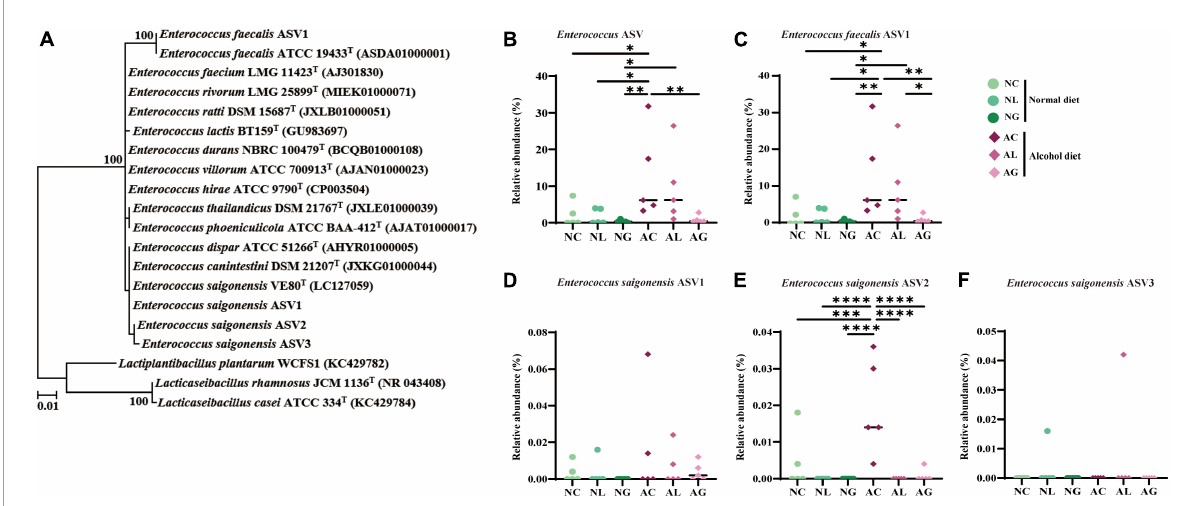
FIGURE6 Phylogenetic analysis and relative abundance of the amplicon sequence variants (ASVs) of Enterococcus . The ASVs assigned to Enterococcus originated from bacterial 16S rRNA gene sequence data of mice fed normal and alcohol diets. (A) Phylogenetic tree based on the 16S rRNA gene sequences and reconstructed using the maximum likelihood algorithm, indicating the taxonomic positions of the ASVs. Further, the 16S rRNA gene sequences of the validated Enterococcus species were included. The bootstrap values are shown on the nodes as percentages corresponding to only 1,000 replicates with values over 70%. Lactiplantibacillus plantarum WCFS1, Lacticaseibacillus rhamnosus JCM 1136 T , Lactobacillus casei ATCC 334 T were used as the outgroup. The scale bar equals 0.01 changes per nucleotide position. Relative abundance of (B) total Enterococcus ASV, (C) Enterococcus feacalis ASV1, (D) Enterococcus saigonensis ASV1, (E) Enterococcus saigonensis ASV2, and (F) Enterococcus saigonensis ASV3. The data were analyzed by performing ordinary one-way ANOVA followed by Fisher’s LSD test. ∗ p < 0.05, ∗∗ p < 0.01, ∗∗∗ p < 0.001, ∗∗∗∗ p < 0.0001. NC, normal diet group; NL, normal diet and Lactiplantibacillus ( Lp .) plantarum DSR J266 + Levilactobacillus ( Lv .) brevis DSR J266 group; NG, normal diet and Lacticaseibacillus ( Lb .) rhamnosus GG group; AC, alcohol diet group; AL, alcohol diet and Lp . plantarum DSR J266 + Lv . brevis DSR J301 group; AG, alcohol diet and Lb. rhamnosus GG group; LSD, least significant